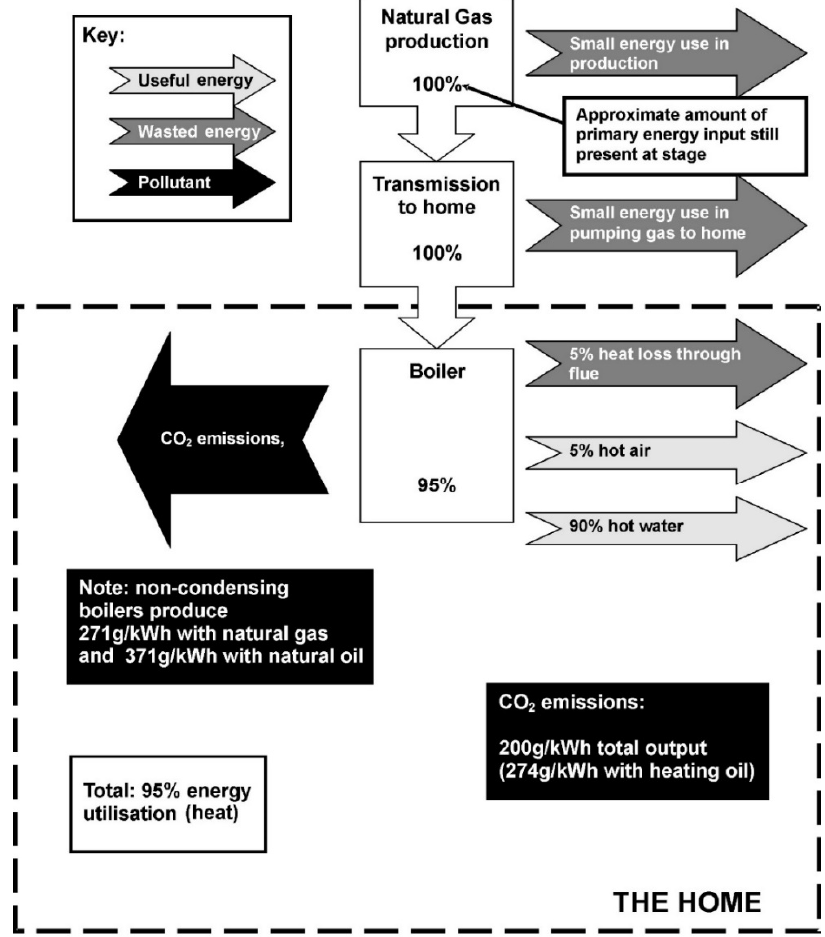
Figure 2. Indicative energy and emissions balances for a modern natural gas-fired central heating boiler (of the condensing type) on a ‘full fuel cycle’ basis. NB: Energy industry use and distribution losses (i.e., small losses in production) currently account for 7% of natural gas supply according to DUKES [19].